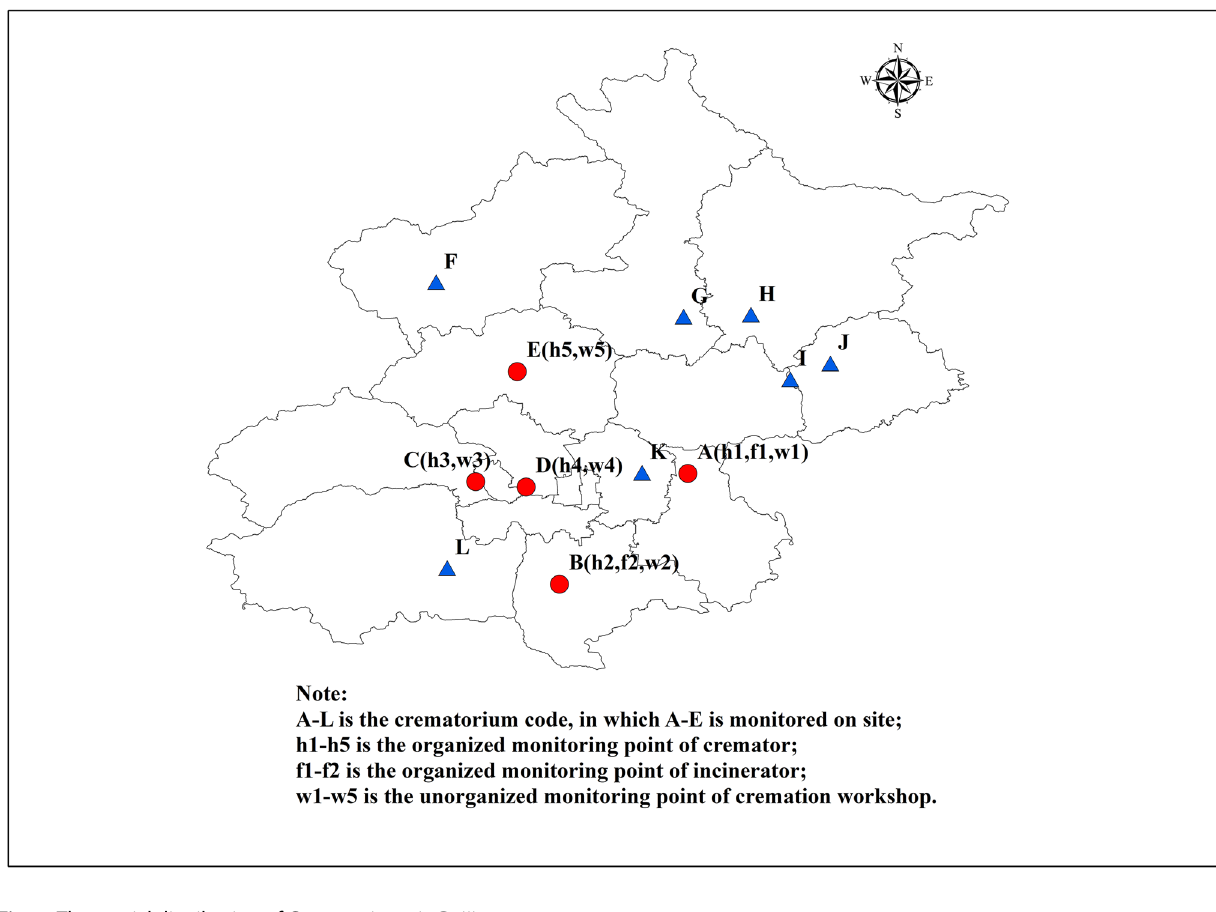
Fig. 1 The spatial distribution of Crematoriums in Beijing